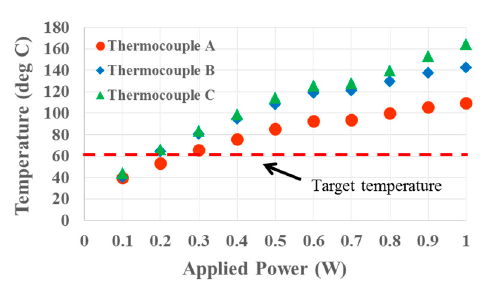
Figure 11. Heating up temperatures vs applied